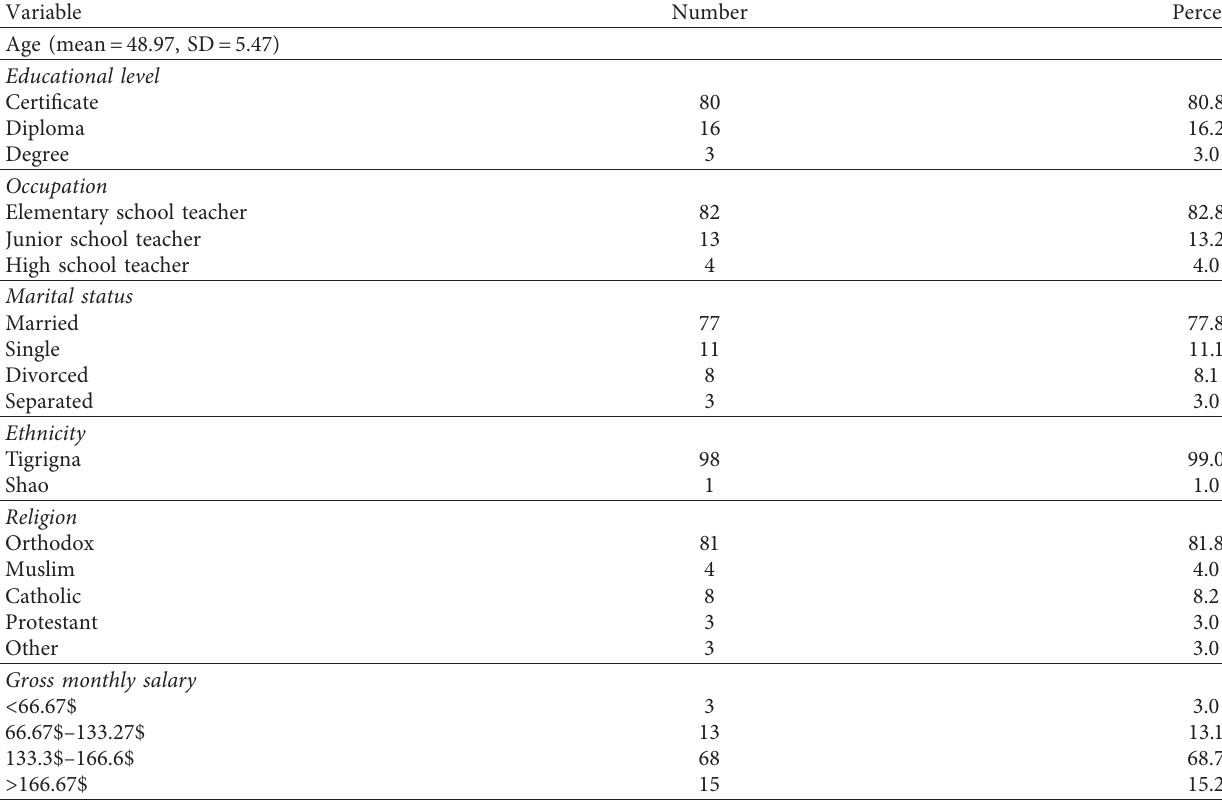
Table 1: Sociodemographic characteristics of the study participants.